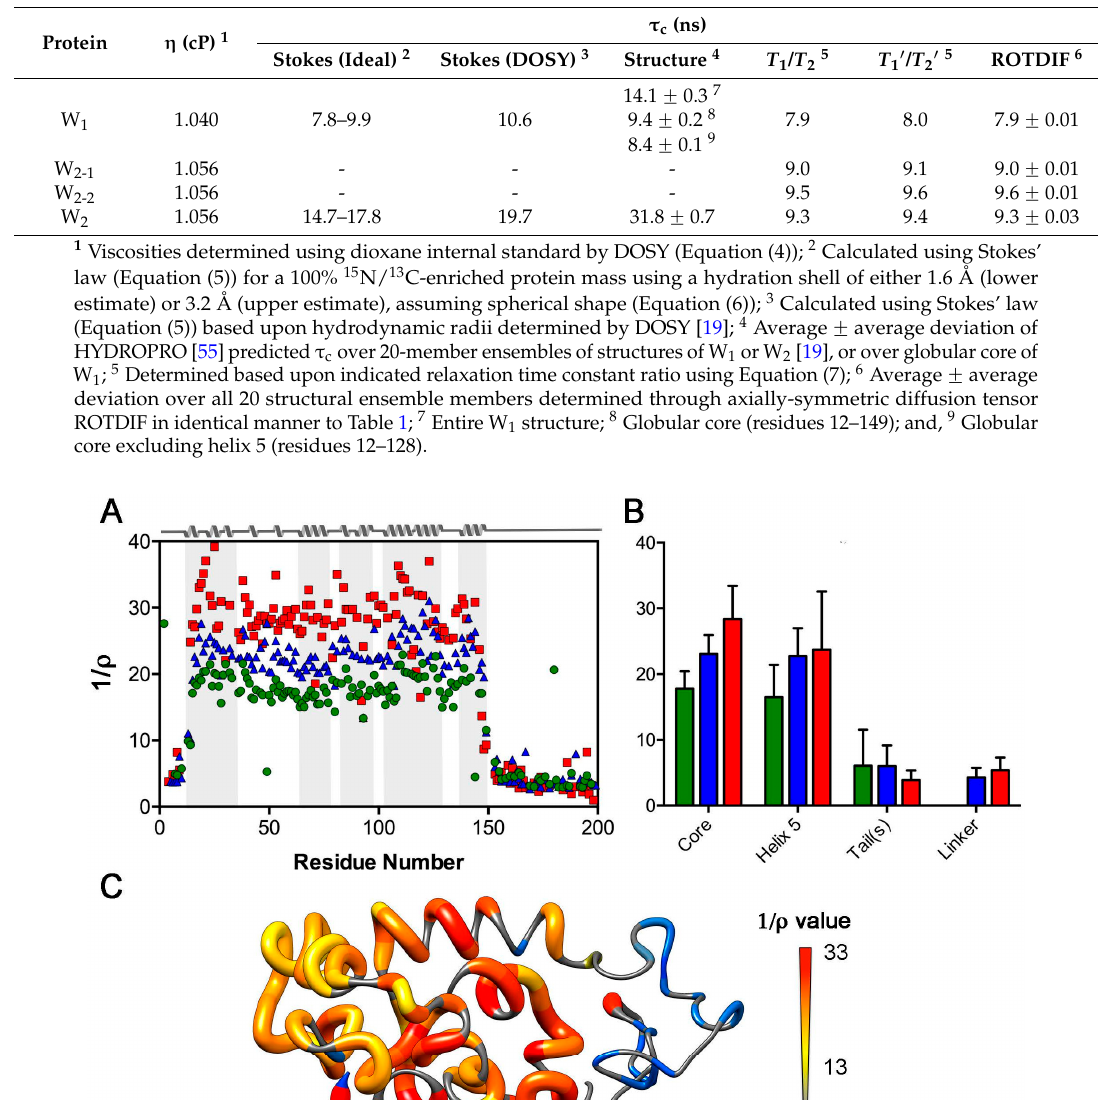
Table 2. Rotational correlation time ( τ c ) for indicated protein according to given method.